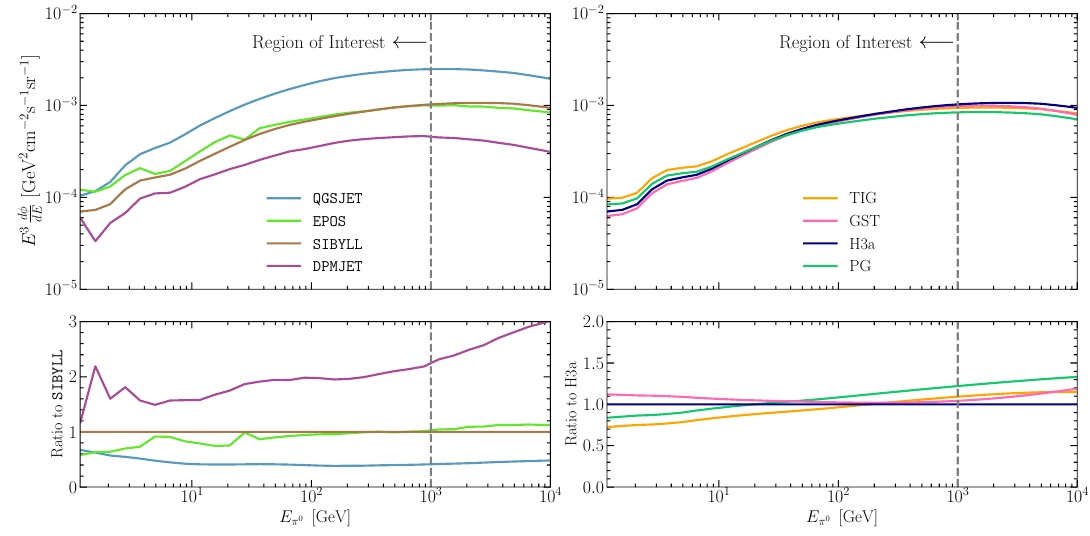
Figure 3 . Production Rate of π 0 in cosmic showers and variations in different HIMs and CRMs. Left: comparison of different hadronic interaction models, including QGSJET (blue), EPOS (green), SIBYLL (brown), and DPMJET (purple). The bottom panel depicts the production ratio relative to SIBYLL.2.3.c, which we use for our production estimates. Right: comparison of production rates for different cosmic ray models: TIG (orange), GST (pink), H3a (blue), and PG (green). The bottom panel shows the ratio relative to H3a, which we use for our production estimates. See text for further discussion of CRMs and